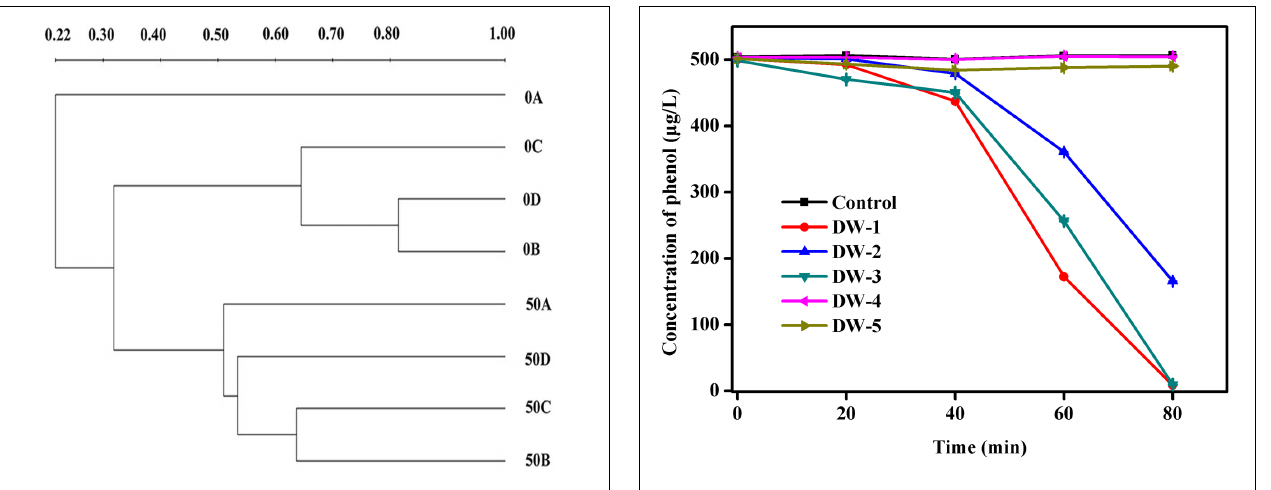
FIGURE 3 | Unweighted pair group method with arithmetic mean (UPGMA) cluster analysis of the relatedness of PCR denatured gradient gel electrophoresis (PCR-DGGE) banding patterns from BAC samples before before phenol acclimation (0A, 0B, 0C, and 0D) and from the final enrichment cultures (50A, 50B, 50C, and 50D).